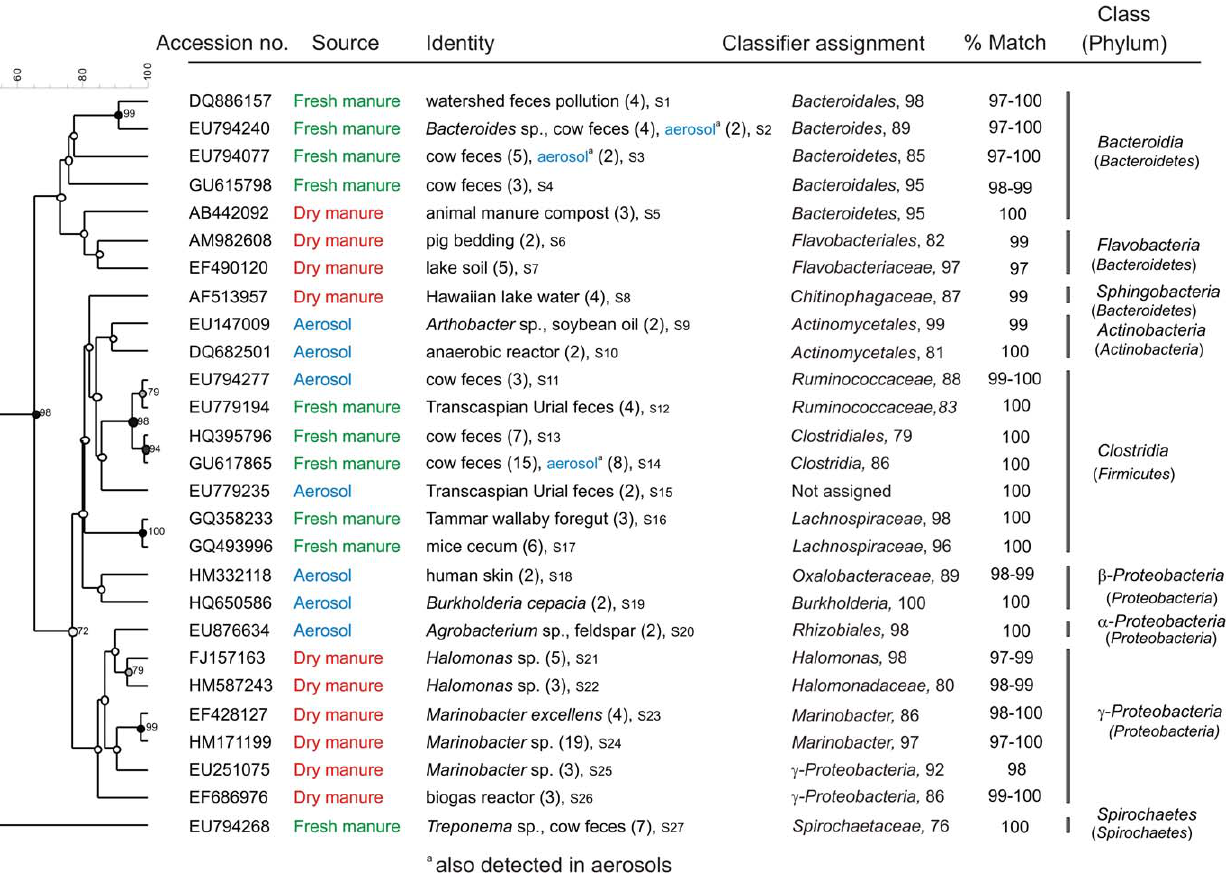
(Table 3). Both Shannon-Wiener and Simpson’s diversity index calculations yielded similar results. Drying the manure appeared to have reduced the species diversity at the Sonoma dairy and aerosolization further reduced the species diversity at the Modesto dairy.